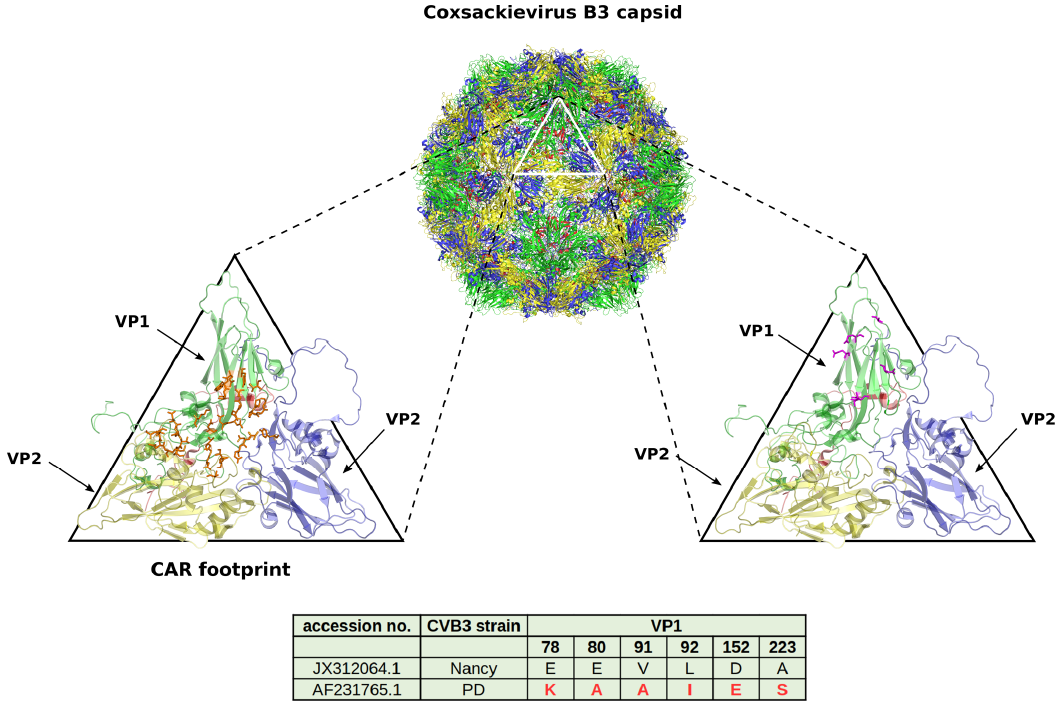
Figure 3. Amino acids of the CVB3 capsid involved in CAR and heparan sulfate binding. Upper image : The capsid is shown along with the tertiary structure of the capsid proteins VP1 (green), VP2 (yellow), VP3 (blue) and VP4 (red). The triangle outlines one asymmetric unit. The structure is modelled with the bioinfomatic software PyMOL (The PyMOL Molecular Graphics System, Version 2.0 Schrödinger, LLC) based on the structural data of CVB3 RD from RCSB protein databank (accession no. 4GB3). Lower left magnified image : the amino acids involved in CAR binding (according to He et al. [86] and Organtini et al. [26]) are shown in orange. Lower right magnified image : the amino acids within one asymmetric unit of CVB3 PD strain (NCBI accession no. AF231765.1) that differ to the CVB3 Nancy strain (NCBI accession no. JX312064.1) are shown in magenta. Their position within VP1 is indicated in the table. The amino acids which differ in the sequence of PD compared to Nancy are involved in binding of the virus to N - and 6- O -sulfated heparan sulfates.